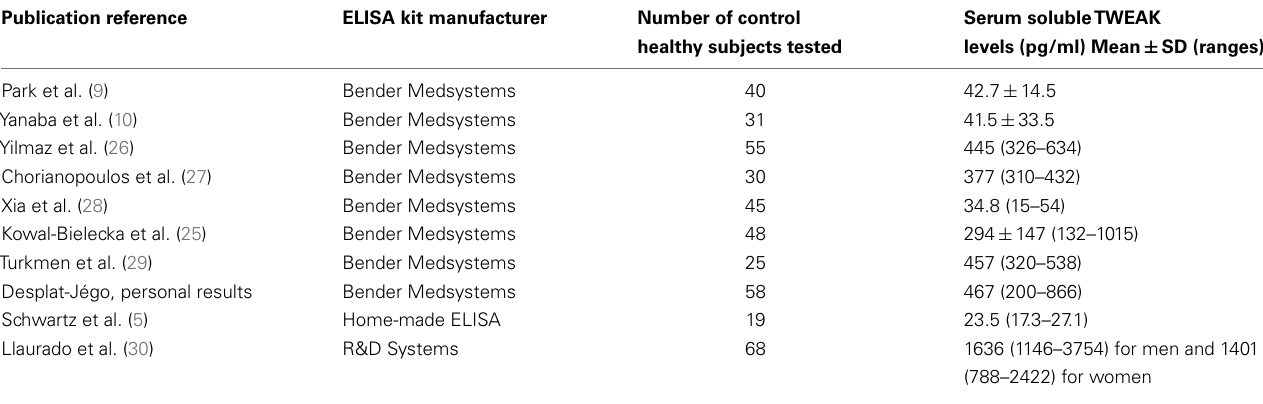
Table 1 | “Normal” mean values and ranges for serum solubleTWEAK in humans determined by ELISA